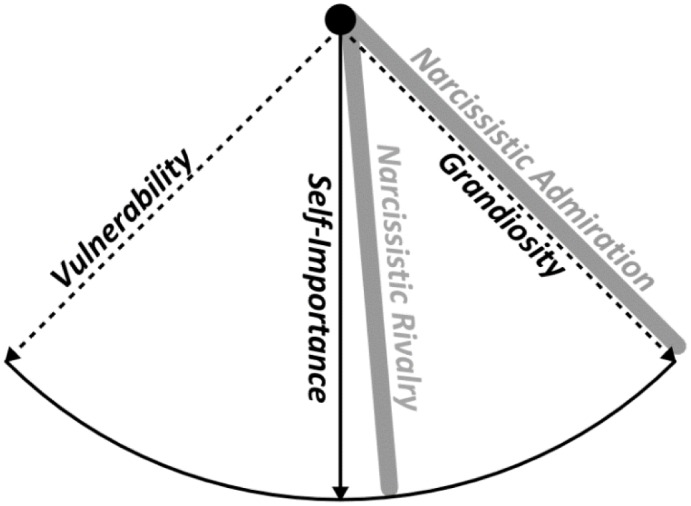
The graphical representation of the Narcissism Spectrum Model in which admiration and rivalry were assigned to the hypothesized dimensions (Krizan and Herlache, 2017).